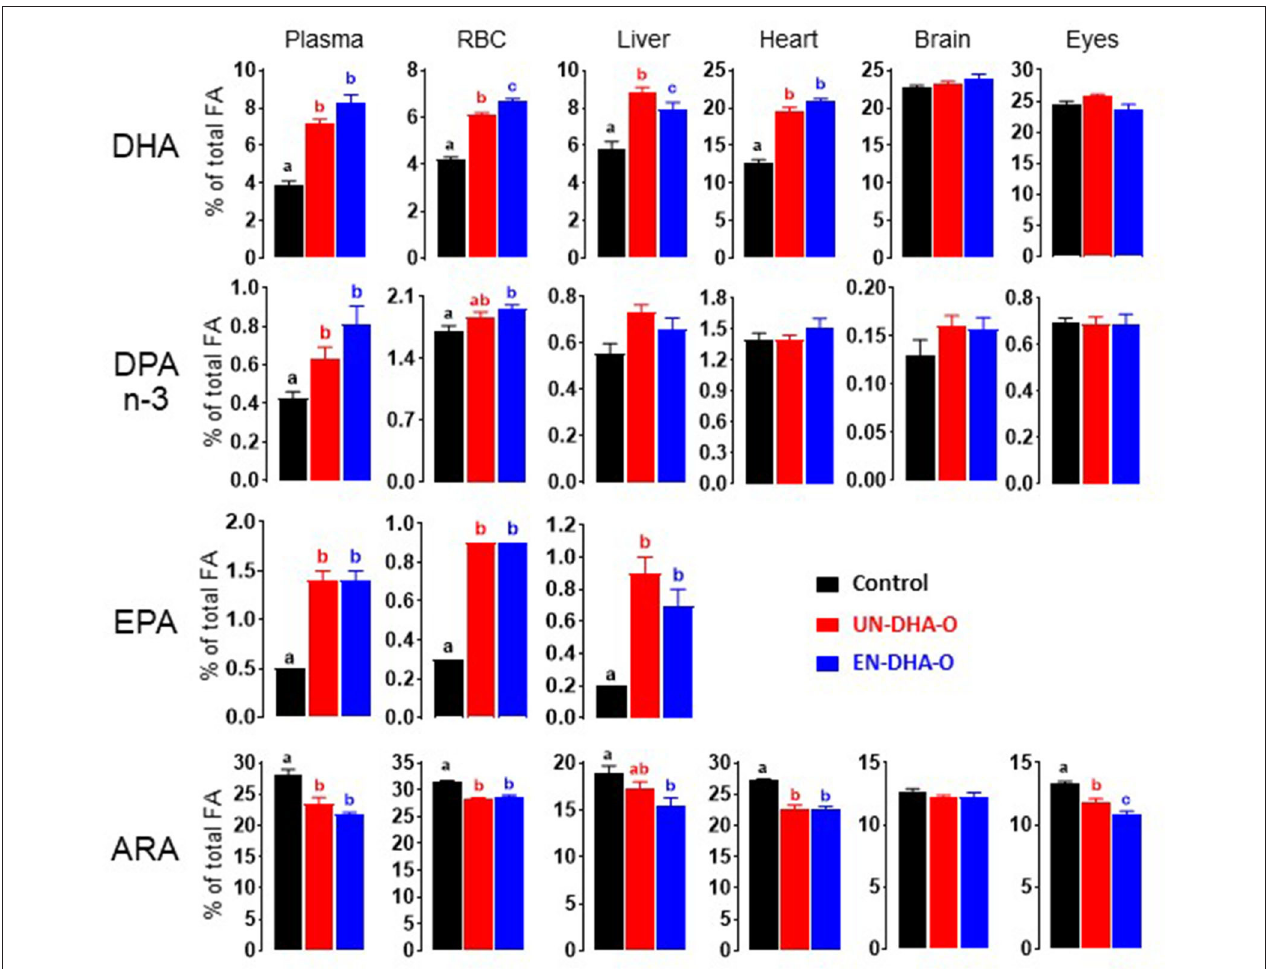
FIGURE 3 | The effect of form of the DHA intake on the FA profile of rat tissues after 4 weeks of treatment. Lipids from rat tissues were extracted according to the Folch’s method and the fatty acid profile was then determined by gas chromatography-mass spectrometry (GC-MS). The main results on n-3 PUFA and arachidonic acid are presented. a, b, c and ab indicate significant differences between the three groups when p < 0.05; ab means no difference with a and no difference with b.